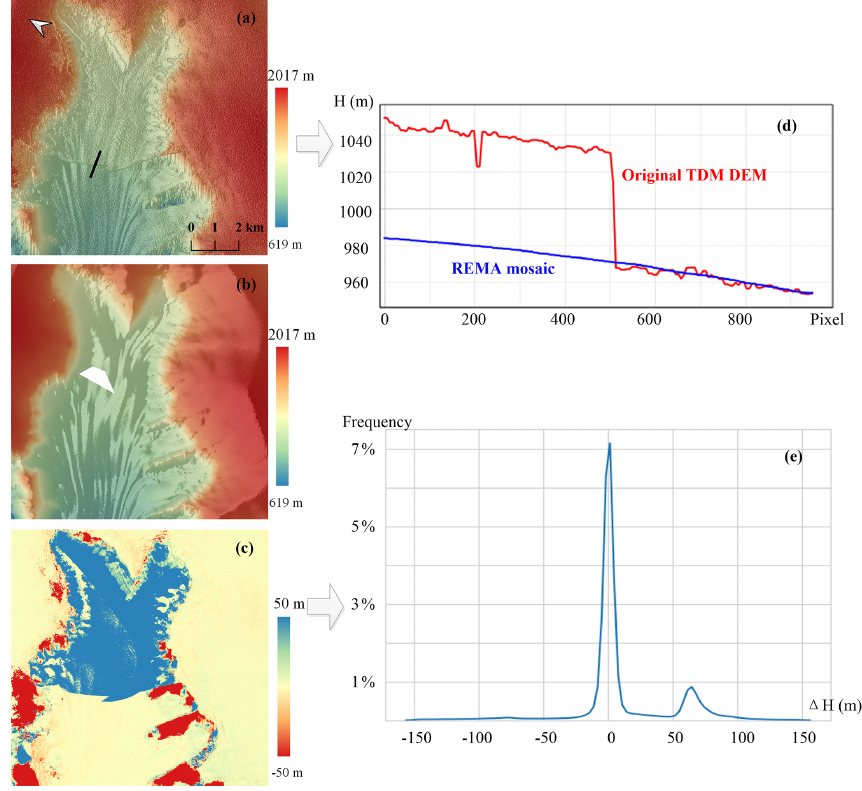
Figure 3. Sample area with residual phase-unwrapping elevation errors. (a) TDM DEM. (b) REMA mosaic with data void in white. (c) Ele- vation difference map between TDM DEM and REMA mosaic. (d) Elevation profile corresponding to the black line in (a) . (e) Histogram of the elevation difference